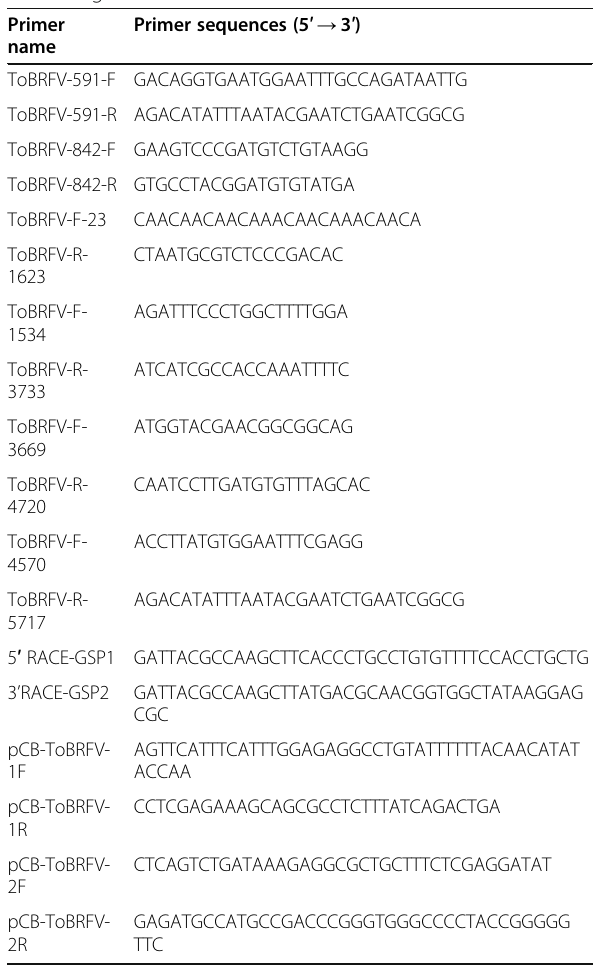
Table 1 Primers used for detection and amplification of tomato brown rugose fruit